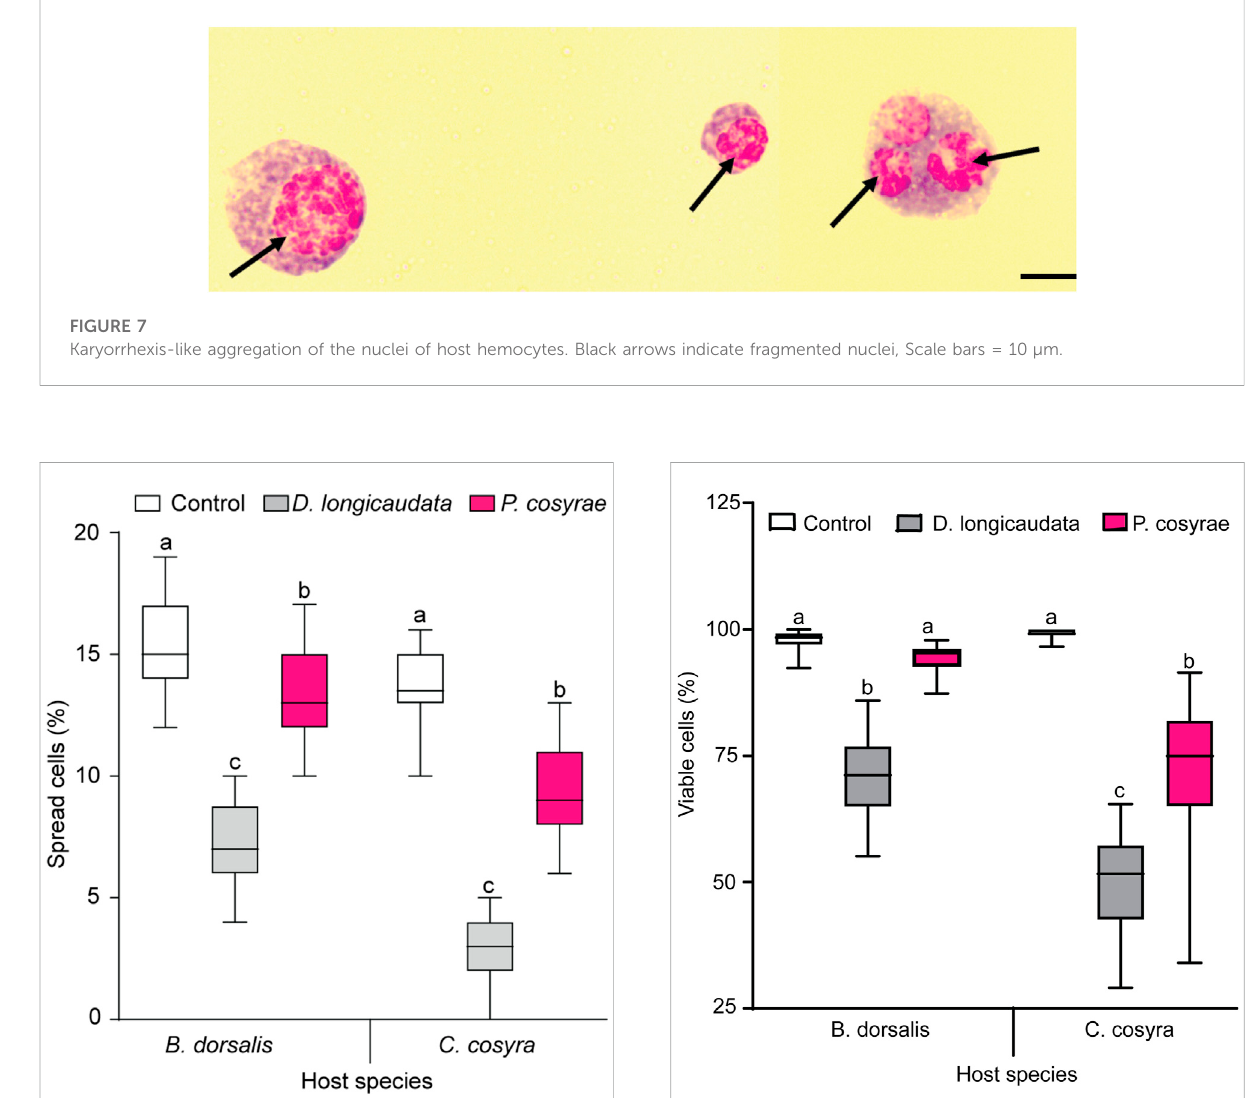
FIGURE 9 Viable hemocytes of B. dorsalis and C. cosyra analyzed 36 h after exposure to D.longicaudata and P. cosyra e:Withineachhost fruit fl y species, boxes with different lower-case letters are statistically different (Tukey tests: p ≤ 0.05, n = 60). Within each box, horizontal lines denote the median values and the ends of each boxplot whisker represent the minimum and maximum of the